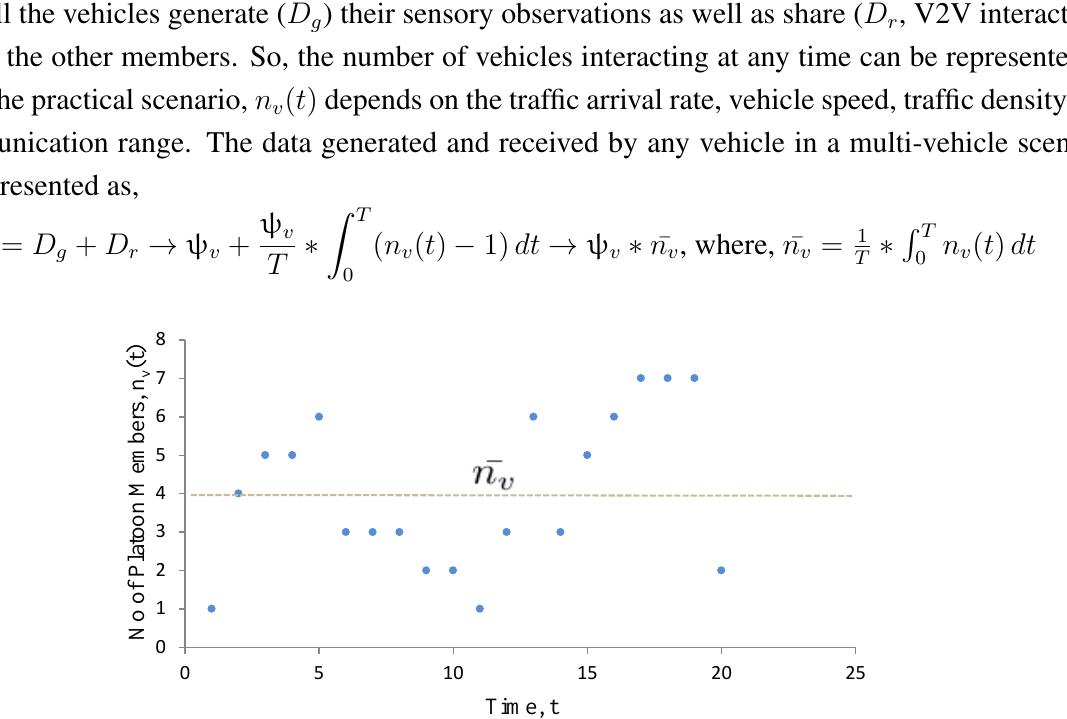
Figure 7. In the extended model, a vehicle becomes member of multi-member platoons over time and will receive sensor data from many neighbour